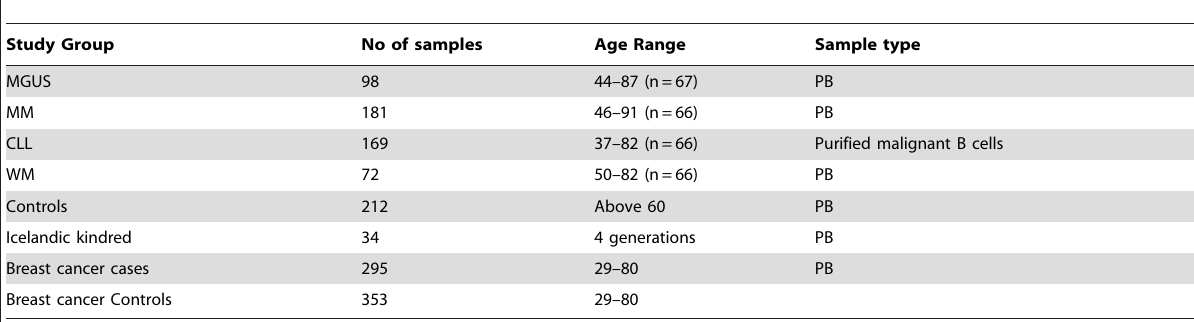
Table 1. Characteristics of study participants (N=